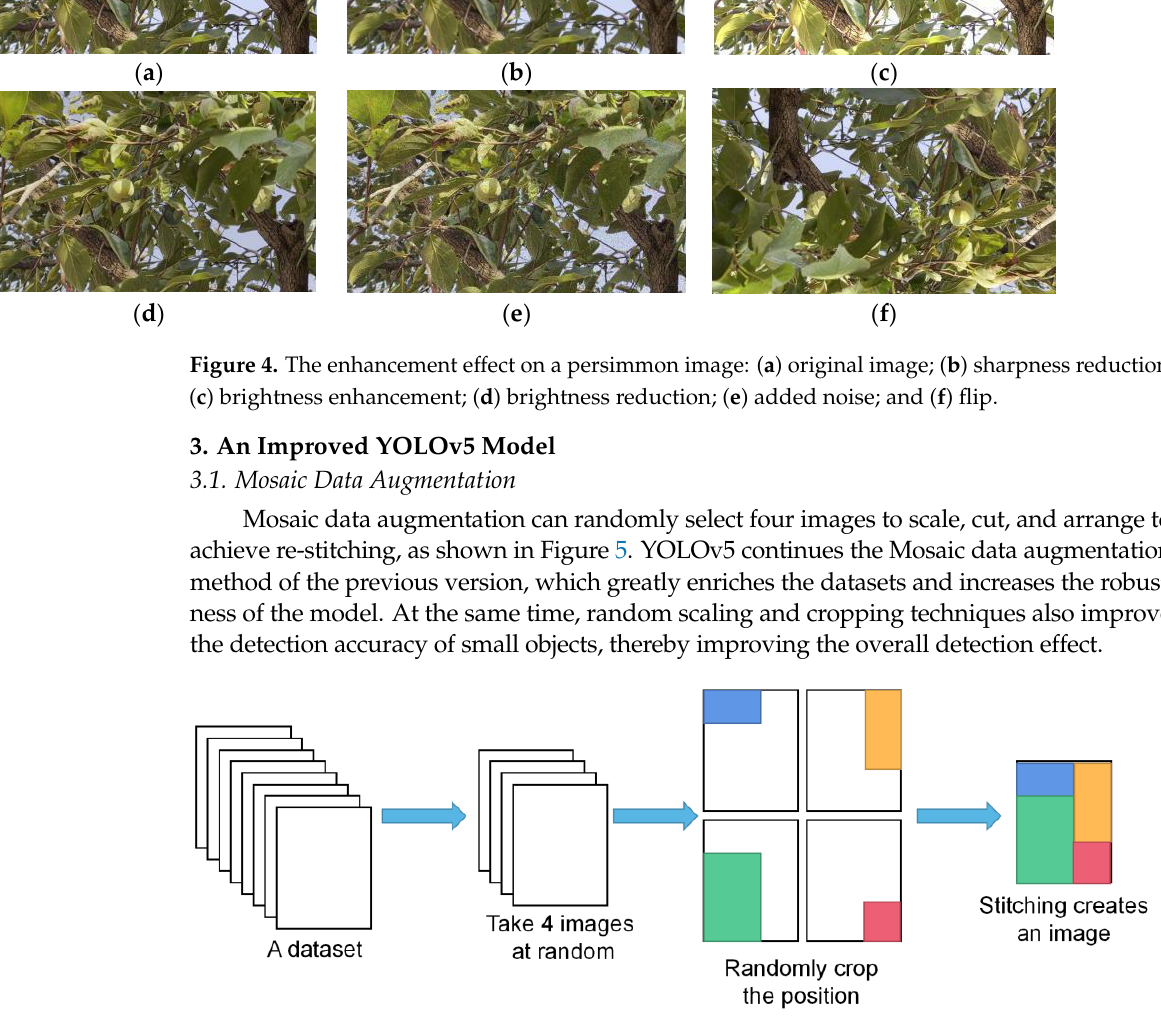
Figure 5. Schematic diagram of the Mosaic data augmentation.